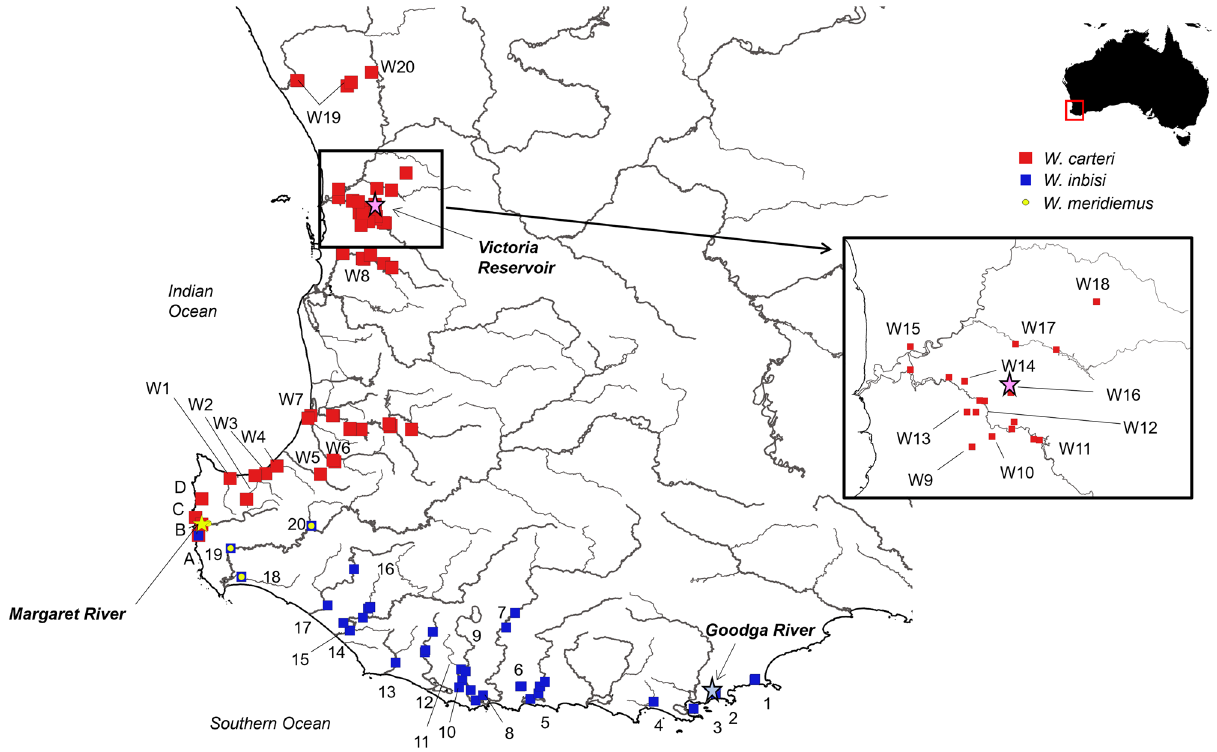
Figure 6. Distribution of the Westralunio specimens used for analyses in this study. Stars indicate type localities, labelled in bold, with colours corresponding to taxa (red— W. carteri , blue— W. inbisi inbisi , yellow— W. inbisi meridiemus ). Waterbodies: South Coast: 1—Waychinicup R, 2—Goodga R, 3—King George Sound (N.B. museum records provided locality which we presume include freshwater streams or rivers